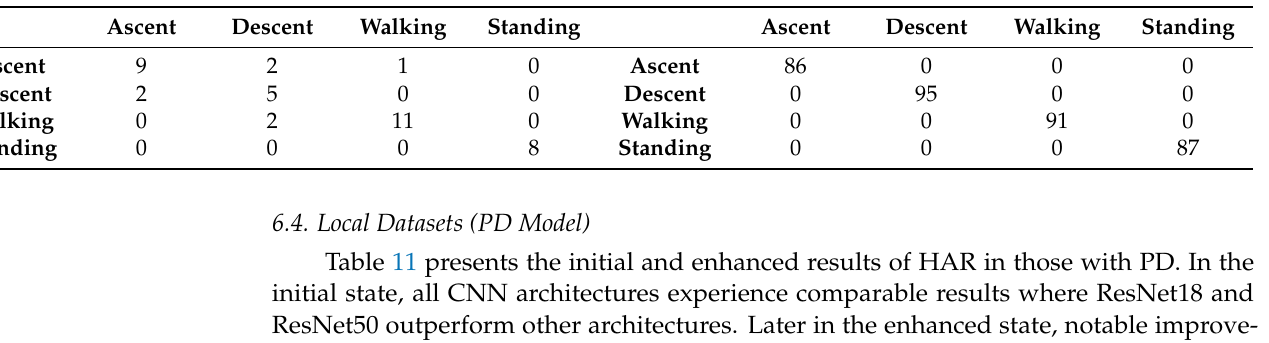
Table 10. Confusion matrix of HS local dataset– ResNet50 (initial results—left, final results—right).